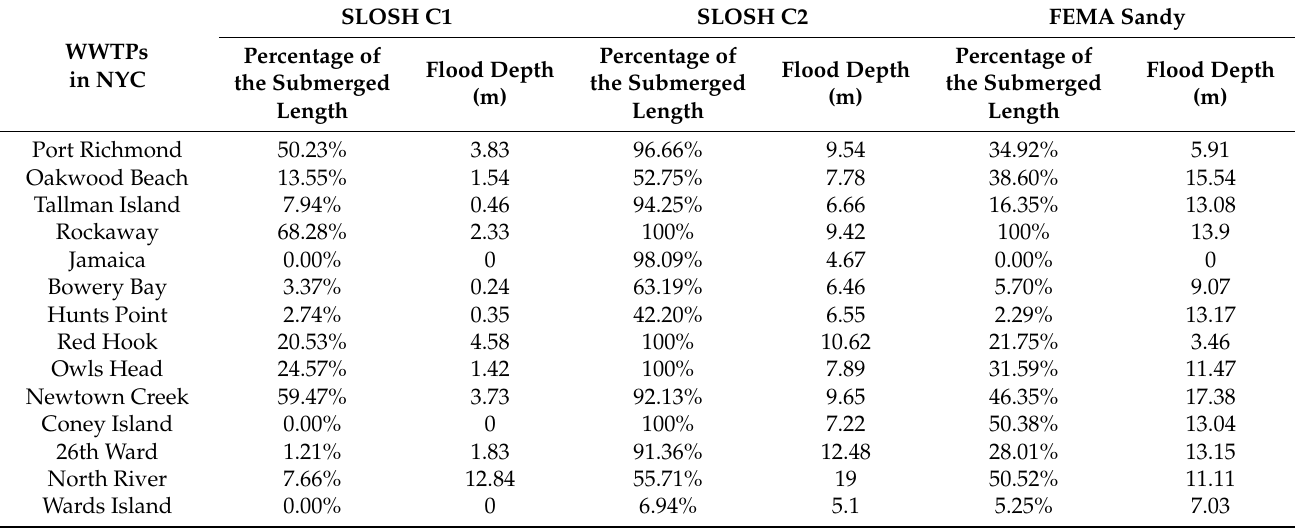
Table 5. Comparison of maximum flood depth between FEMA MOTF Sandy, SLOSH C1, and C2 hurricanes.